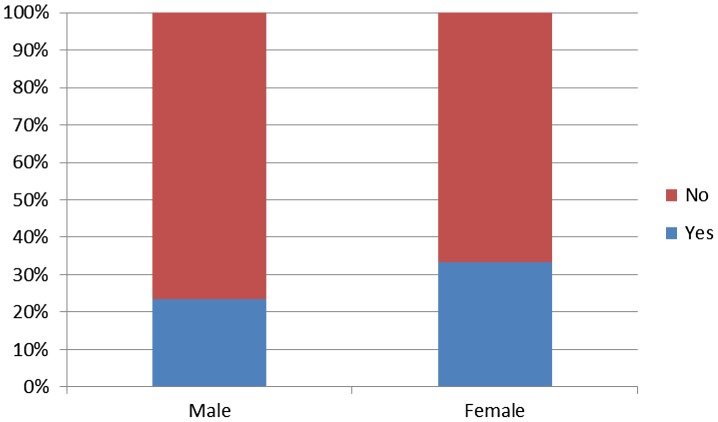
Percentage of patients who correctly knew the national physical activity guidelines divided into gender.